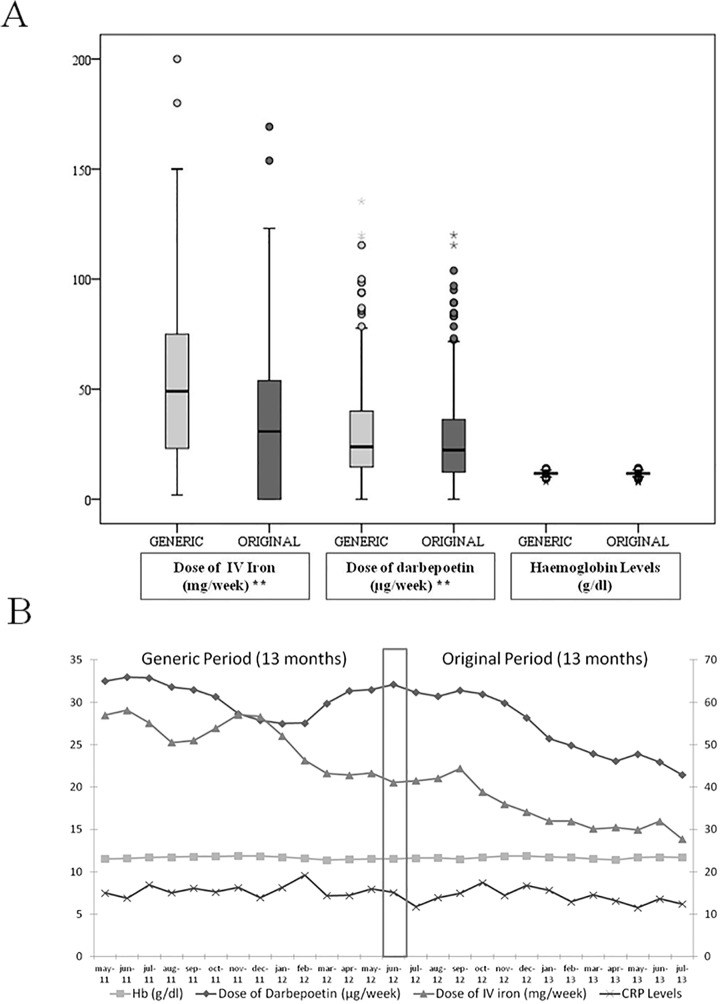
Haemoglobin, intravenous iron and darbepoetin doses in each period (2A) and monthly (2B).